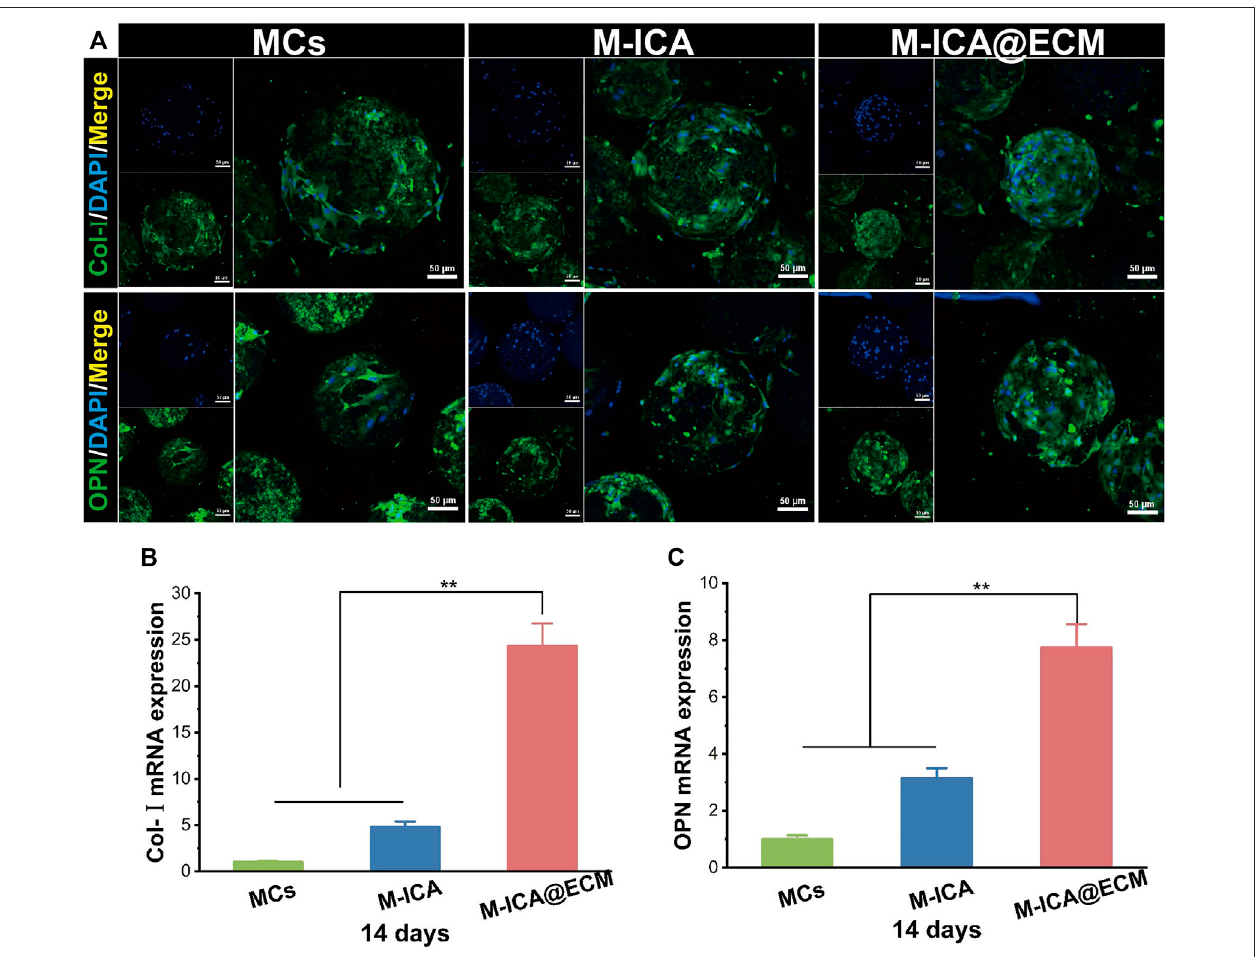
FIGURE 8 | The expression of osteogenesis-related genes and proteins: (A) Immuno fl uorescent images of Col-I and OPN expressed by BMSCs cultured on the different microcarriers for 14 days which were observed under CLSM (Scale bar = 50 μ m); (B,C) qRT-PCR analysis of Col-I and OPN. (* p < 0.05, ** p < 0.01, n = 3).